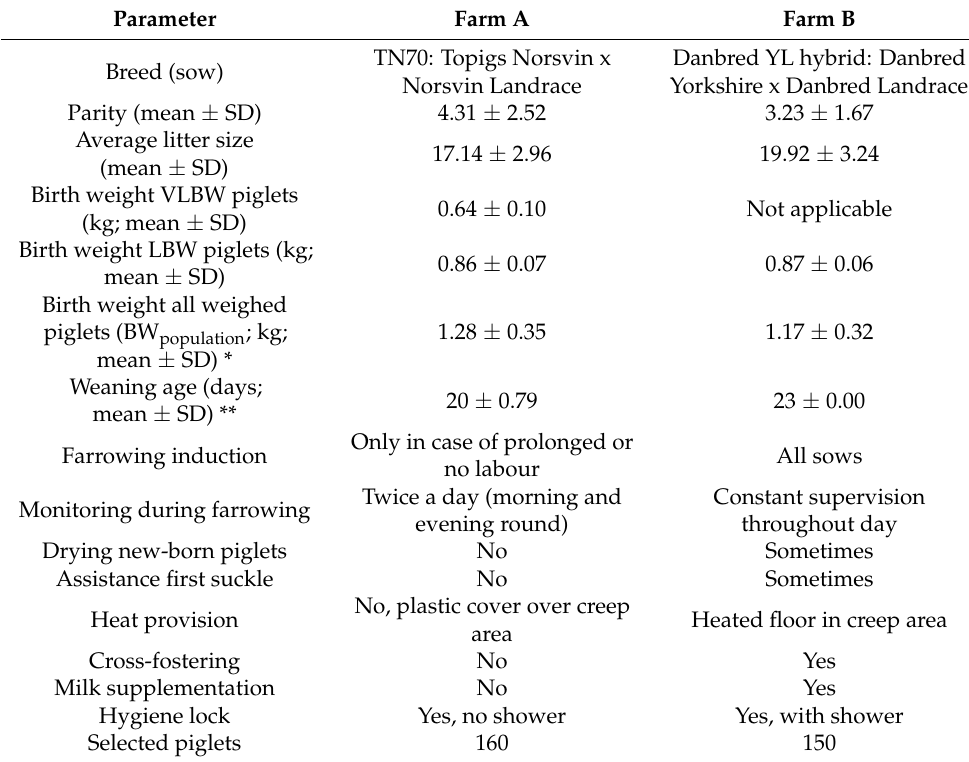
Table 1. Farrowing management at the two farms, the sows, the very low birth weight (VLBW), and low birth weight (LBW) piglets that were used during the